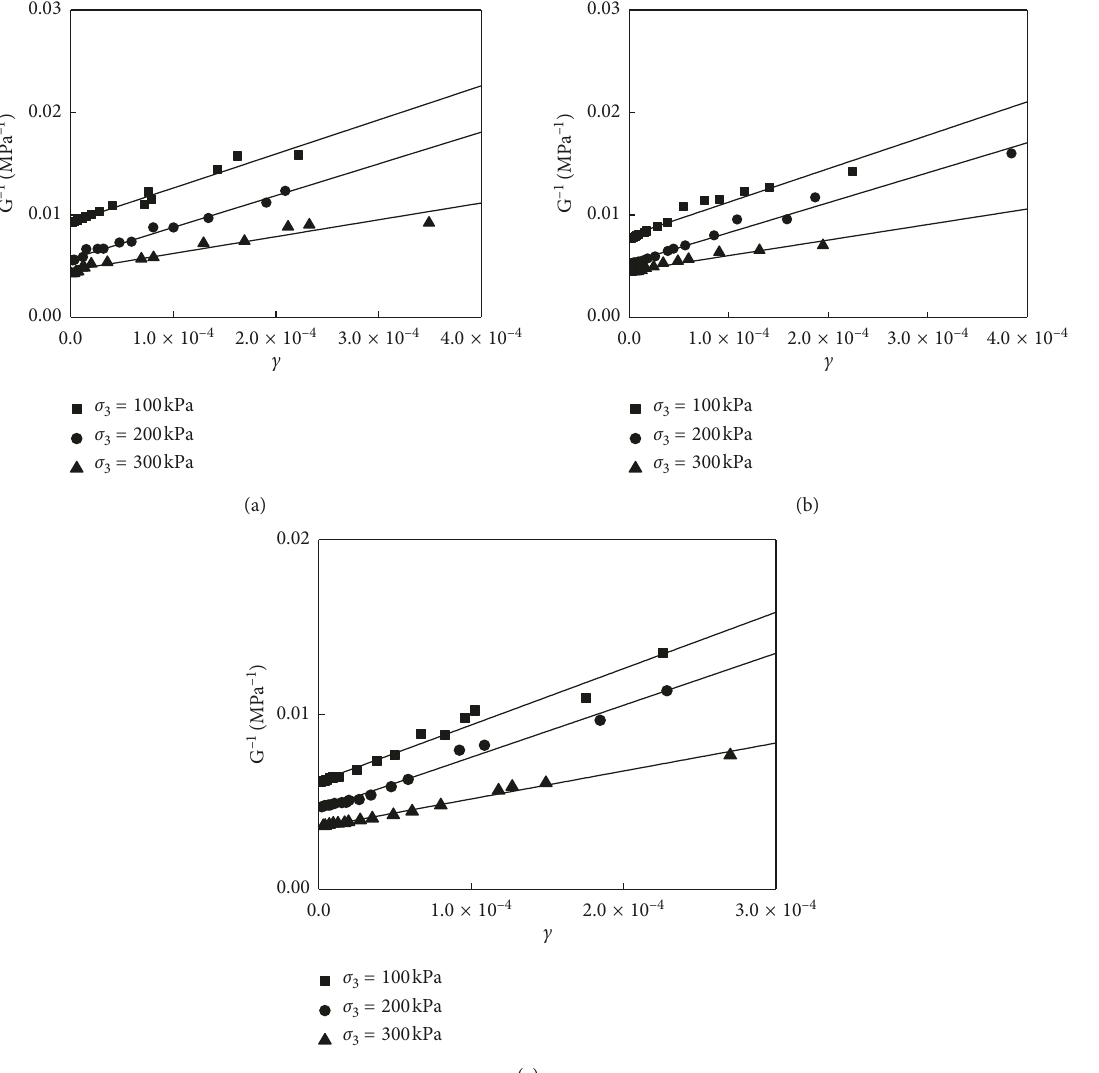
� 0.3; (b) D � 0.5; (c) D � 0.7. r r r